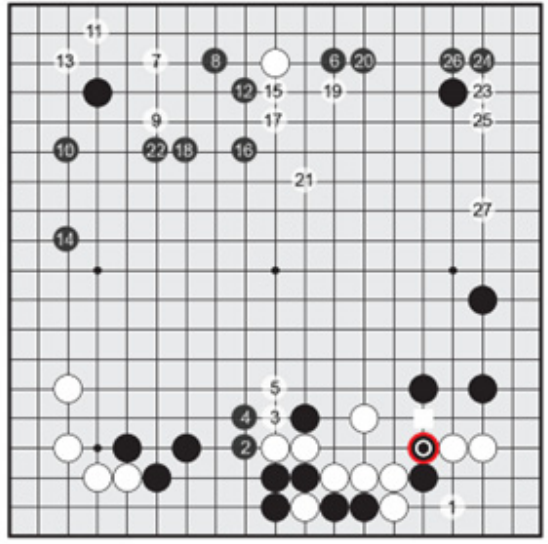
Figure 2. A variation reference to Figure 1 (Figure 5f in [15]). Reprinted/adapted with permission from Ref. [15]. Copyright year: 2016, copyright owner’s name: DeepMind”.